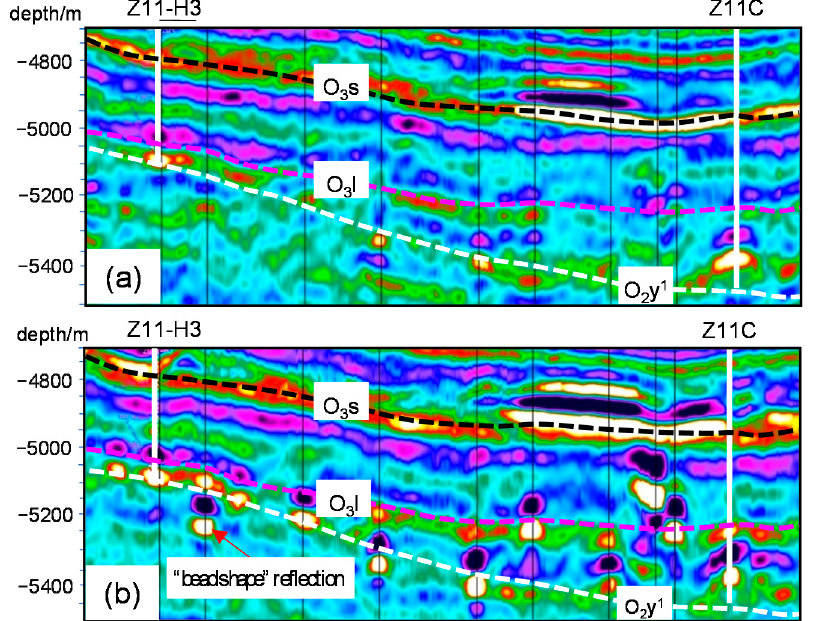
Figure 6. Comparison of seismic sections between conventional acquisition data ( a ) and the high- density seismic acquisition data ( b ) in the central uplift (the “bead shape” reflections showing the large fracture-cave reservoirs; O 3 t: base of the Upper Ordovician Sangtamu Formation; O 3 l: base of the Upper Ordovician Lianglitage Formation; O 2 y 1 : base of the first member of the Yingshan For- mation).